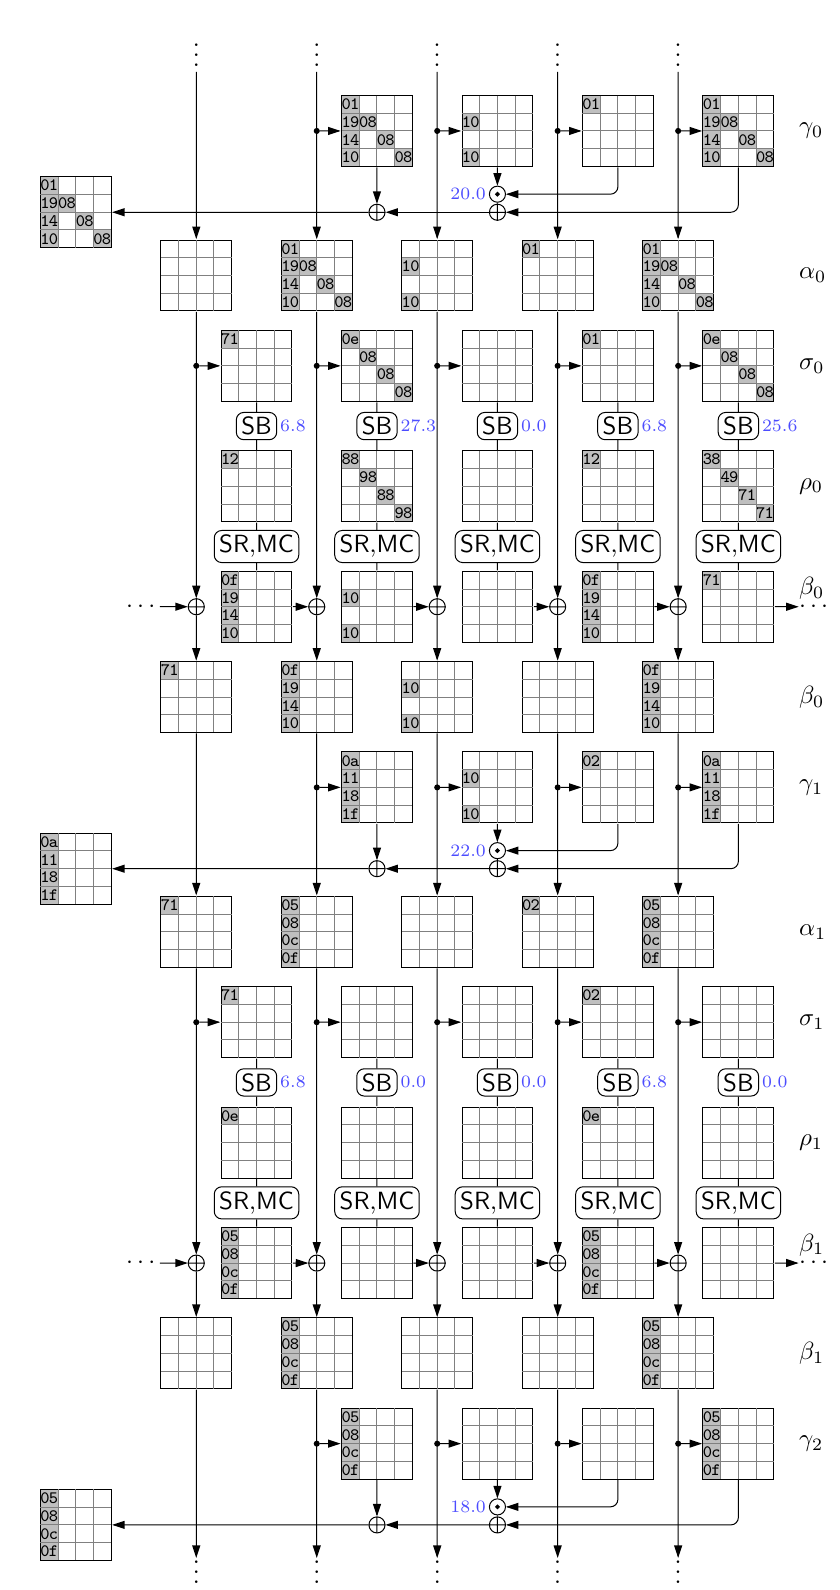
Figure 5: Linear approximation for AEGIS -128 with squared correlation contribution 2 − 140